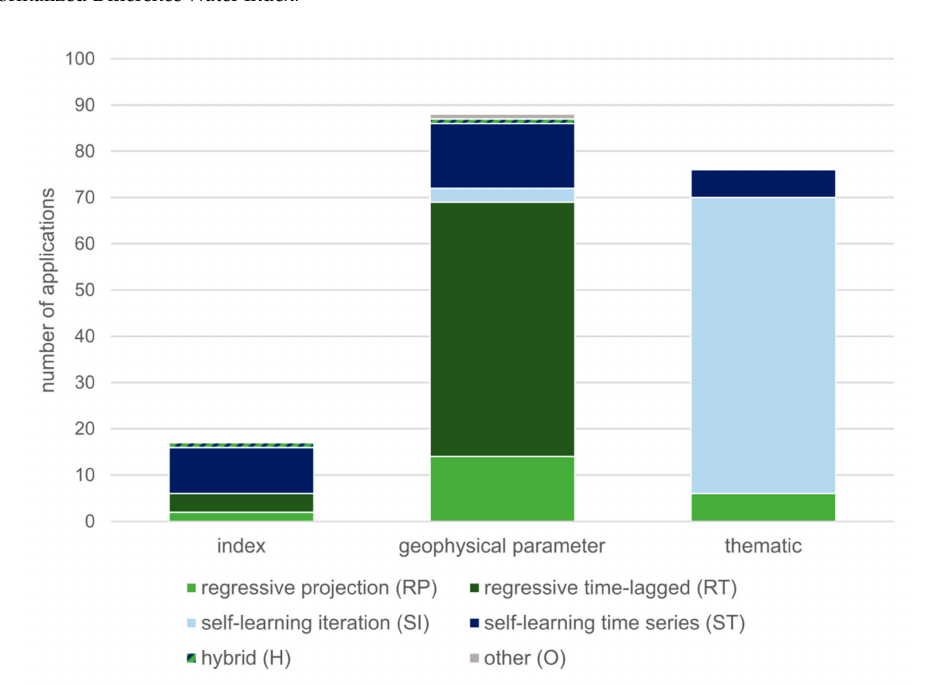
Figure 8. Number of forecasting methods applied in each category of remotely sensed feature types. Examples for feature types are given in Table